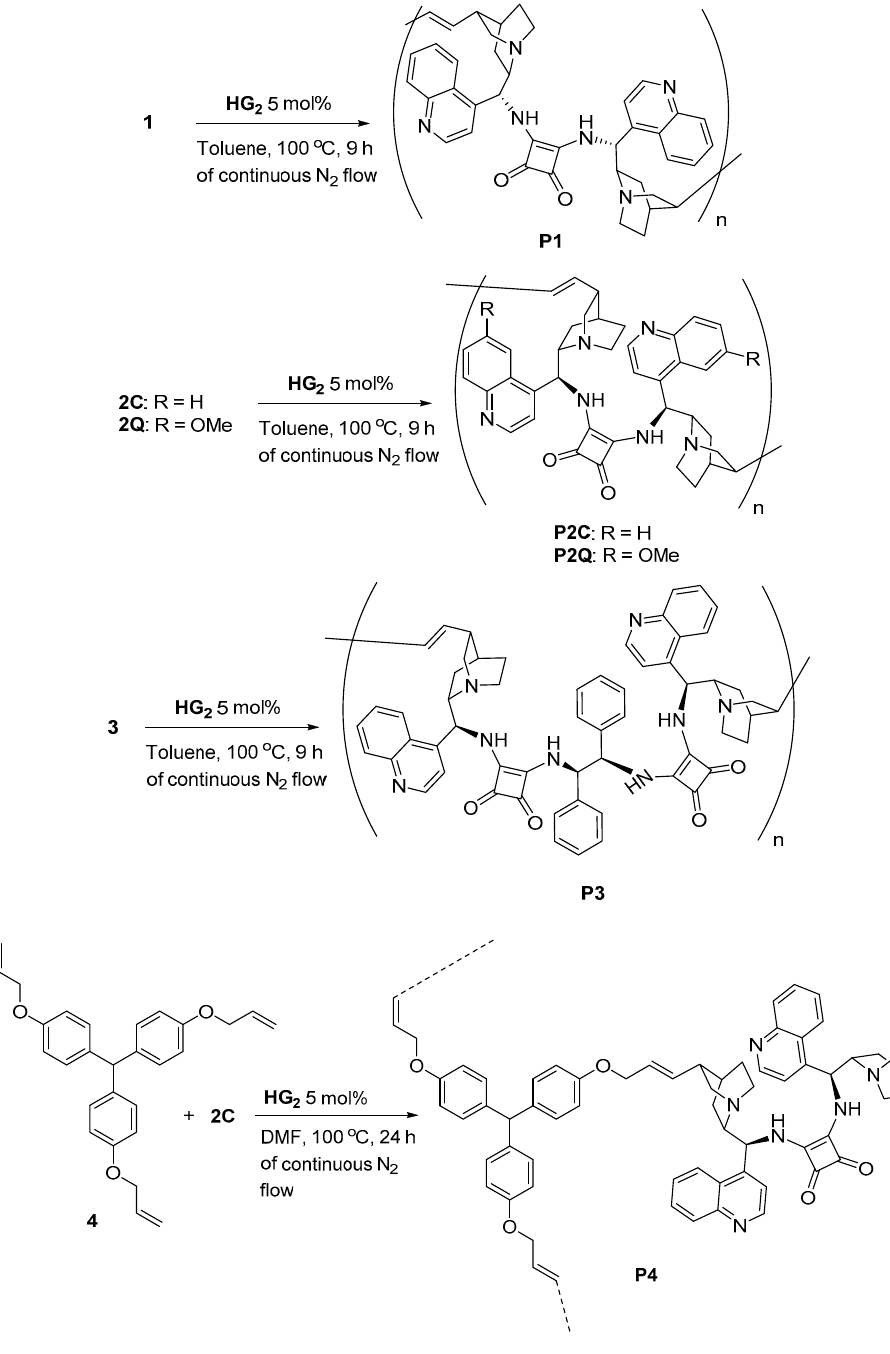
Scheme 1. Synthesis of P1 – P4 from 1 – 4 , using HG 2 . Table 1. Synthesis of P1–P4 by acyclic diene metathesis (ADMET) polymerization a .